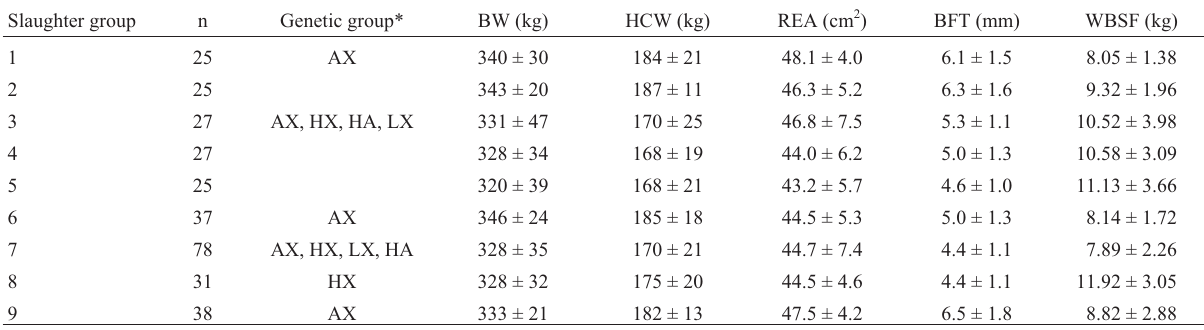
Table 1 - Slaughter groups, showing number of steers (n), final body weight (BW), hot carcass weight (HCW), rib eye area (REA), backfat thickness (BFT) and Warner-Bratzler Shear Force (WBSF) for each genetic group (AX, HX, HA, LX). Values represent mean ± standard deviation (SD). Slaughter group n Genetic